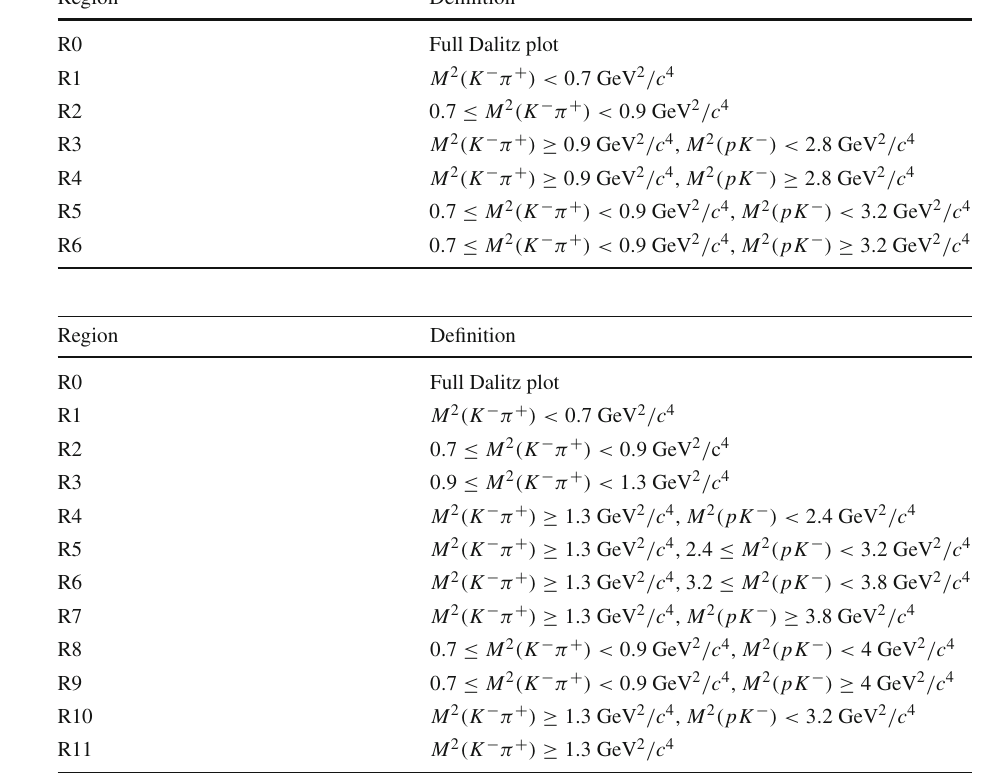
Table 1 Definitions of the Dalitz plot regions for the control mode, Λ + c → pK − π +